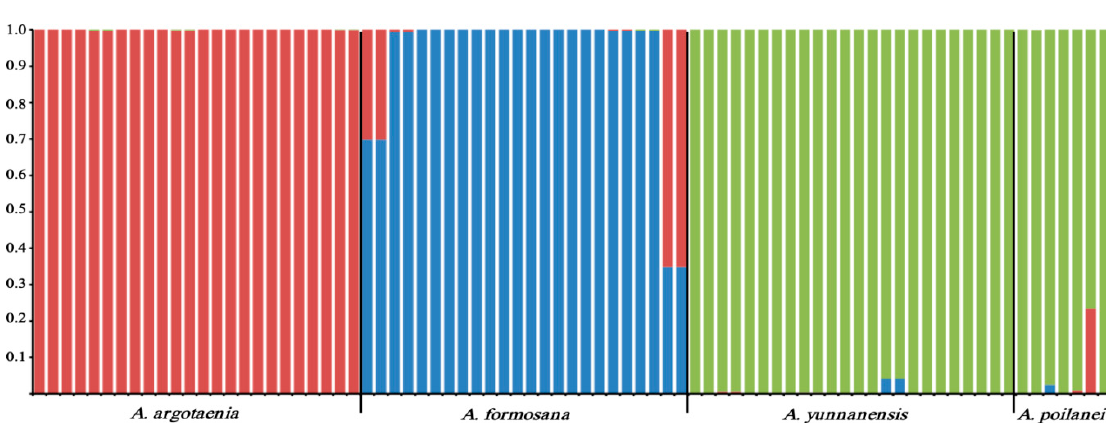
Figure 4. Genetic composition of Amentotaxus species in three clusters (K = 3) were detected through STRUCTURE analyses by using the highest Δ K value.